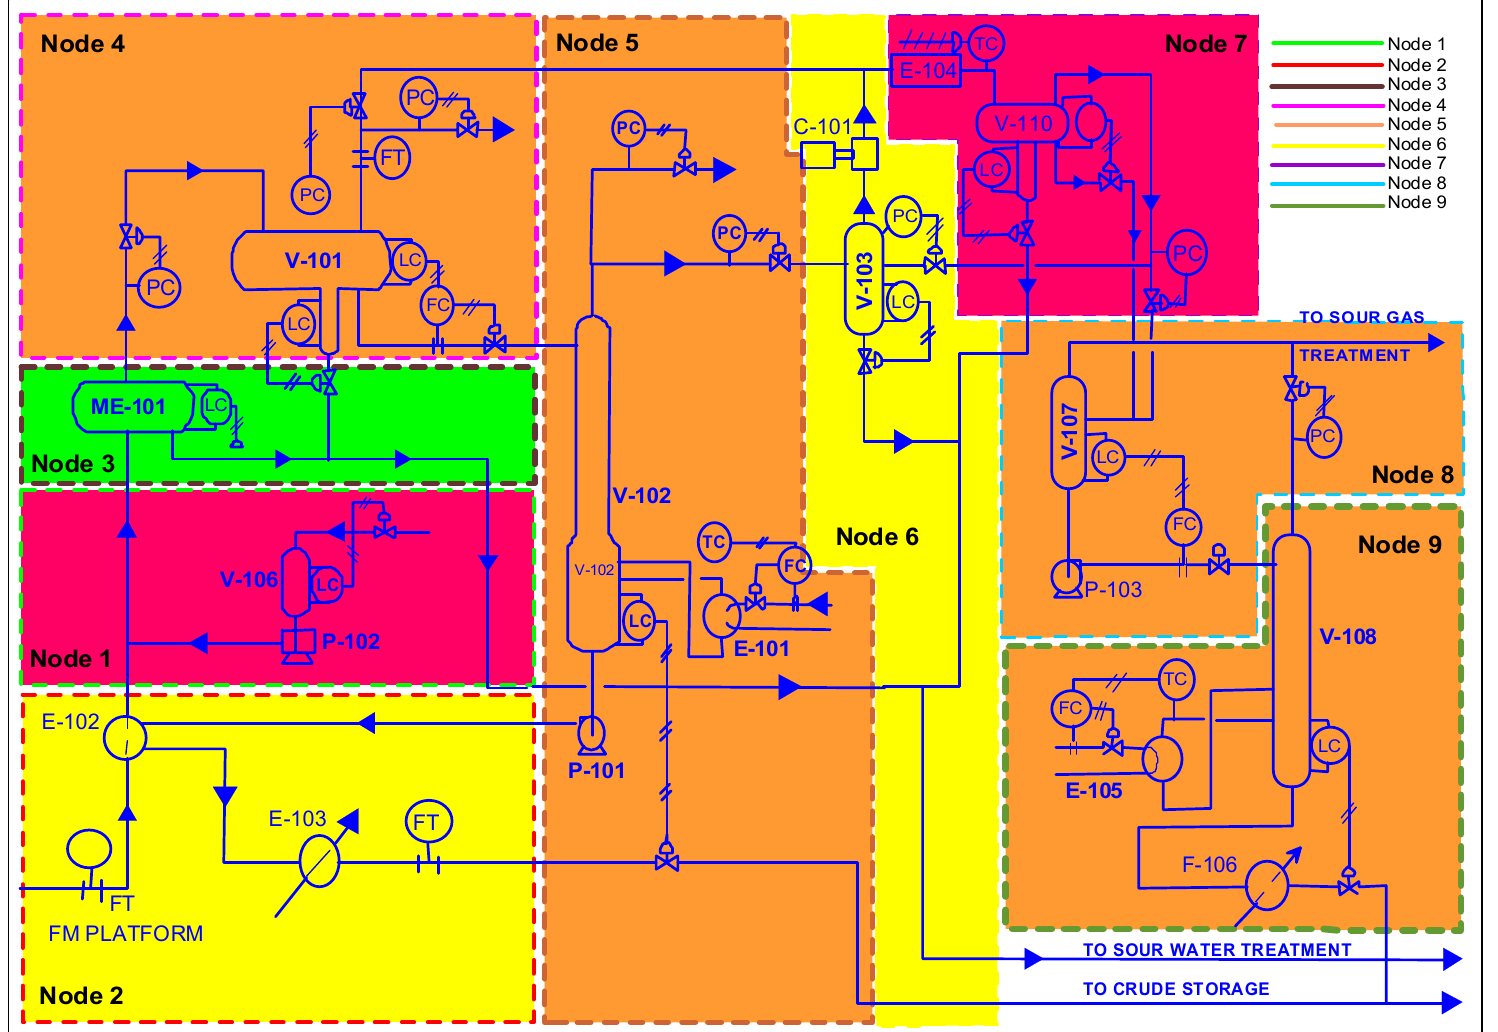
Figure 6. Safety-color mapping by the application of the synergetic HAZOP-DMRA-SCM method at the workplaces of a SCOPI.